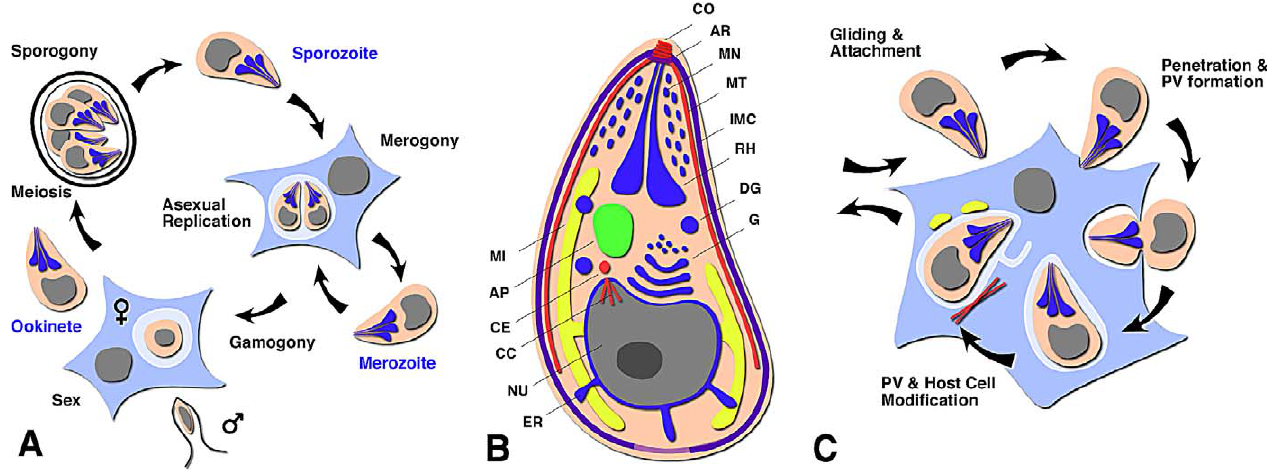
Figure 1. Apicomplexa Are Intracellular Parasites (A) Highly simplified apicomplexan life cycle. Apicomplexans are haplonts, and meiosis (sporogony) immediately follows fertilization. Fertilization might occur within a host cell or extracellularly, giving rise to an oocyst or, less frequently, an invasive stage zygote (ookinete). (B) Schematic representation of a zoite (not all structures are present in all apicomplexans). AP, apicoplast; AR, apical rings; CC, centrocone; CE, centrosome; CO, conoid; DG, dense granule; ER, endoplasmic reticulum; G, Golgi; IMC, inner membrane complex; MI, mitochondrion; MN, microneme; MT, subpellicular microtubule; NU, nucleus; RH, rhoptry. (C) Zoites actively invade the cells of their hosts, establishing a specialized parasitophorous vacuole (PV) (in some species the parasite lyses the vacuole and develops freely in the